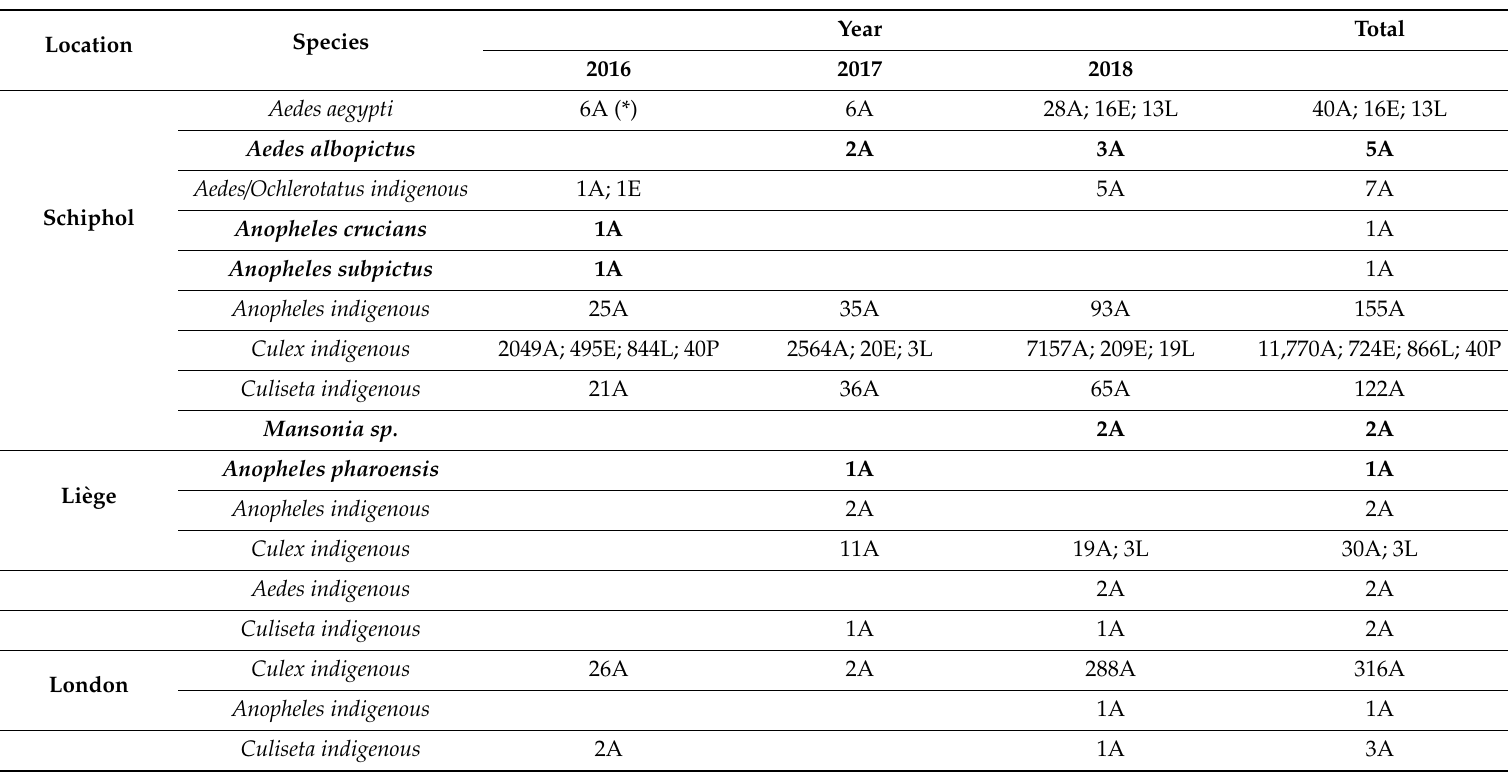
Table 3. Number of specimens collected at Schiphol (the Netherlands), Li è ge (Belgium), and London (Heathrow and Gatwick, United Kingdom) airports. (*) Published in [8]; A: adult, E: egg, L: larva, P: pupa. Results on non-indigenous species are indicated in